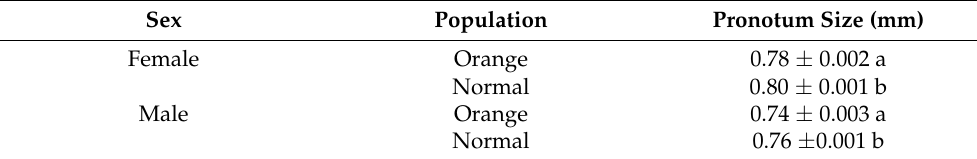
Table 3. Mean body size (width of pronotum) of orange and normal adult males and females. Sex Population Pronotum Size (mm) Female Orange 0.78 ± 0.002 a Normal 0.80 ± 0.001 b Male Orange 0.74 ± 0.003 a Normal